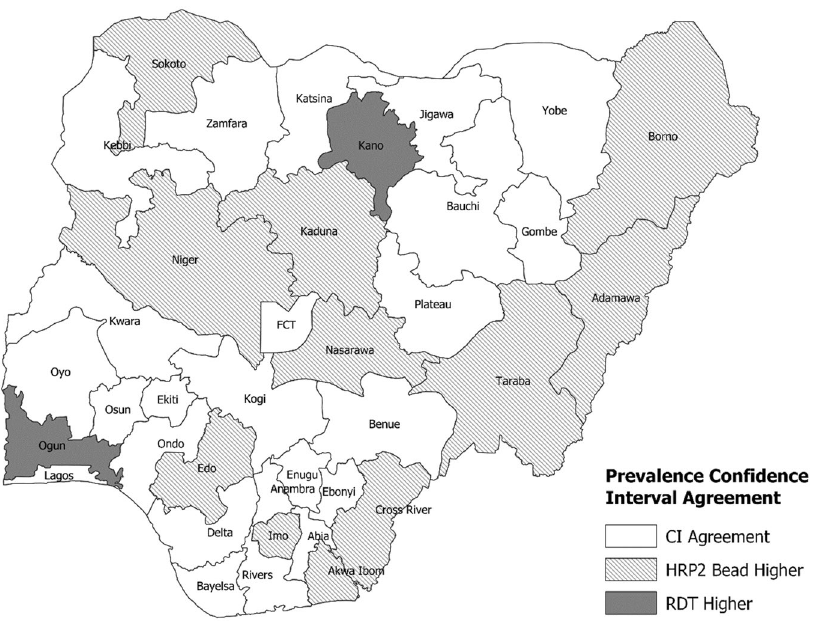
Figure 5. HRP2 bead assay versus RDT prevalence estimate agreement by 95% confidence interval (CI) for each Nigerian state. CI agreement is noted only if HRP2 bead assay prevalence point estimates are within respective RDT prevalence confidence intervals by state and vice versa. Otherwise, the state is classified based on the higher prevalence measure. Map was generated using QGIS version 3.12.2 (www. qgis.